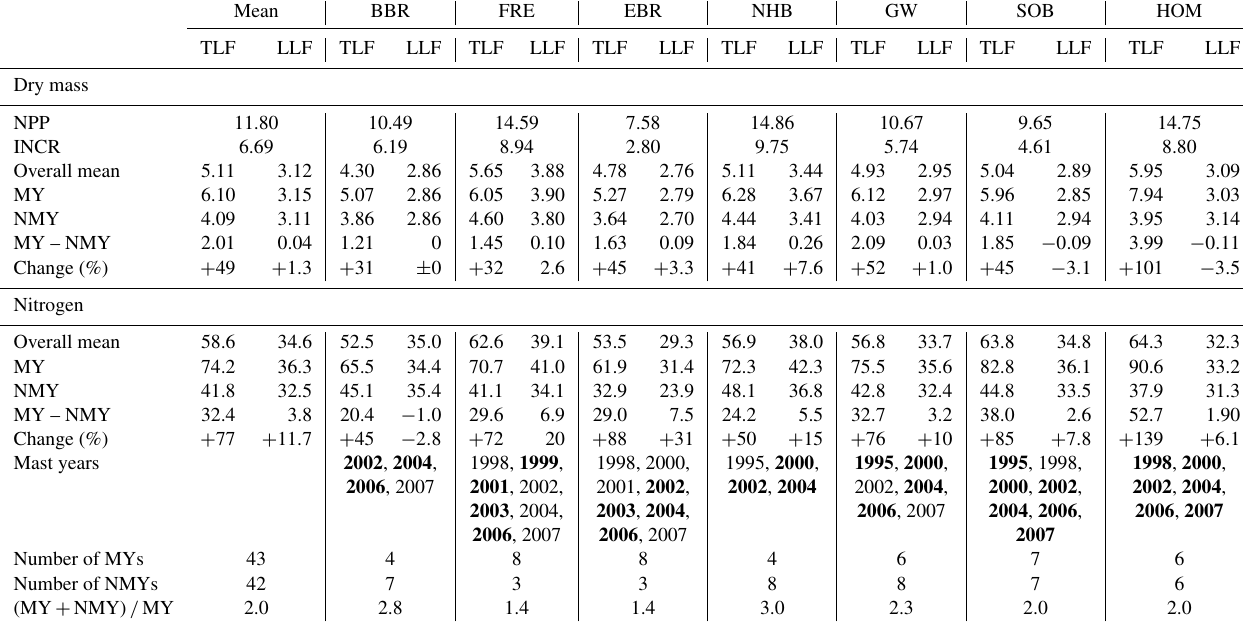
Table 3. Aboveground annual net primary production (NPP) and annual tree increment (INCR) (Mgdrymassha − 1 ) at the study sites during the period 1995–2008. Annual means of dry weight (Mgha − 1 ) and nitrogen (kgha − 1 ) of total litterfall (TLF) and leaf litterfall (LLF) for all years (overall mean), for years with mast (full- and half-mast) (MY), for non-mast years (NMY), and the difference between mast and non-mast years (change %) for seven beech forests. Years with mast (full-mast years in bold) and the number of mast and non-mast years and years between mast events are given for the study sites.